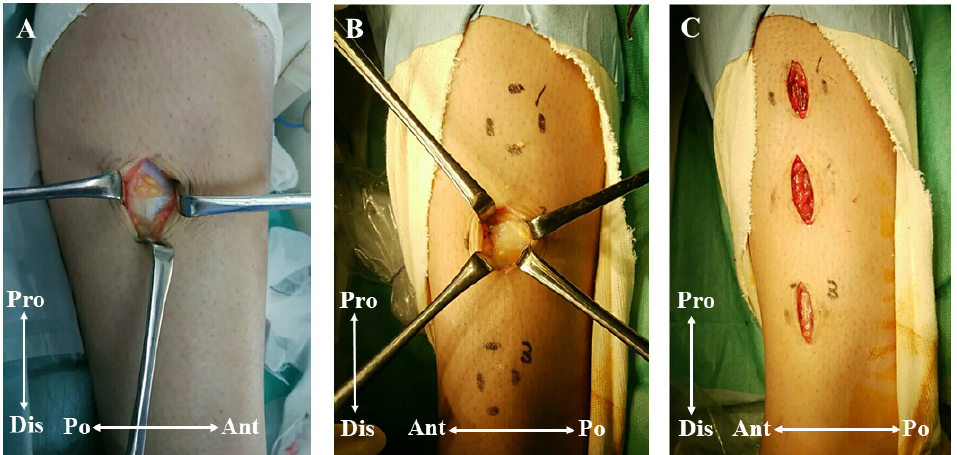
Figure 4. Intraoperative photographs. ( A ) The right lower extremity before fasciotomy. The crural fascia of the lesion was very thin. ( B ) The left lower extremity before fasciotomy. The crural fascia of the lesion was also very thin. ( C ) The left lower extremity after fasciotomy. Surgical incisions were made just over each lesion. Pro, proximal; Dis, distal; Po, posterior; Ant, anterior. Postoperatively, the ankles were not immobilized, and weight bearing was allowed as tolerated. Ankle range-of-motion exercises were initiated immediately after surgery. Several days after surgery, he presented with paresthesia and impaired touch sensation over the dorsal area of the left foot. At the three-month follow-up, a swelling lesion with hard elasticity was identified between the middle and the most distal surgical wounds.